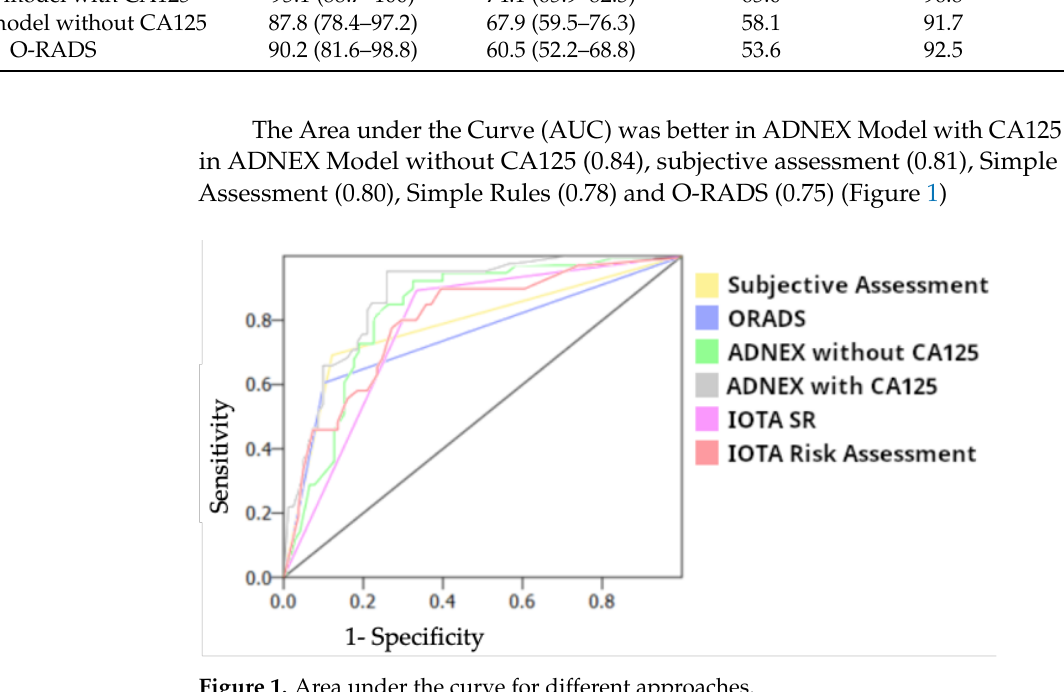
Figure 1. Area under the curve for different